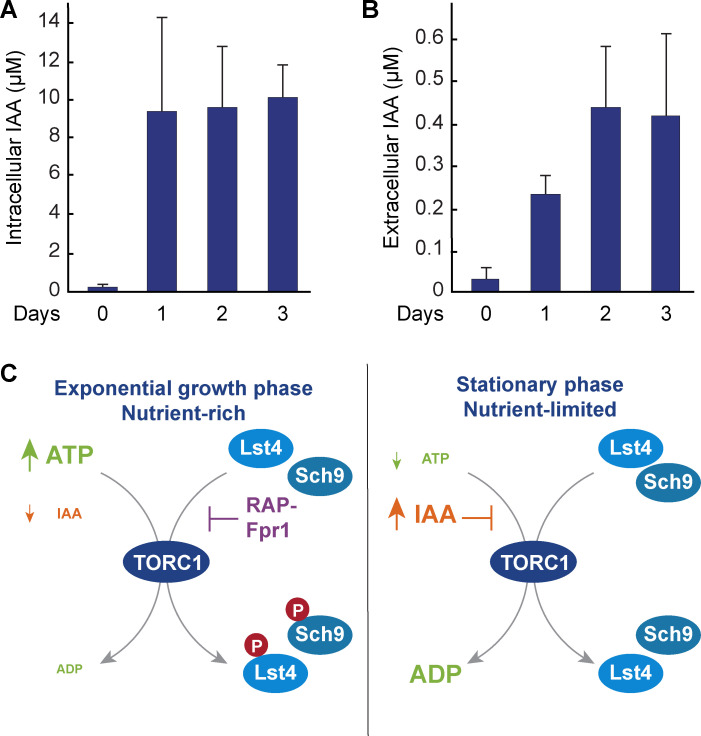
IAA accumulates in stationary phase cells.(A, B) The intracellular (A) and extracellular (B) concentrations of IAA (n = 3; +SD) were determined in exponentially growing (BY4741) wild-type cells (0) and in cells grown to stationary phase for the indicated number of days. (C) Indole-3-acetic acid (IAA) acts as an ATP-competitive inhibitor of TORC1 in nutrient-starved stationary phase cells. In cells growing exponentially on nutrient-rich media, ATP levels are high (about 3mM; [82]) and IAA level are low (< 0.05 μM; [83]). Under these conditions, TORC1 is able to phosphorylate substrates such as Lst4 and Sch9 [69, 72]. In complex with Fpr1, rapamycin binds to the FRB domain near the entrance of the catalytic cleft of TORC1, thereby interfering with the recruitment of substrates to the active site [93]. In stationary phase cells, intracellular ATP levels drop below 56 μM [82, 83], while the ones of IAA increase up to 10 μM (Fig 5A), which, based on the kinetic parameters elaborated here (see text for details), would enable IAA to efficiently compete for ATP and thereby contribute to TORC1 inhibition.